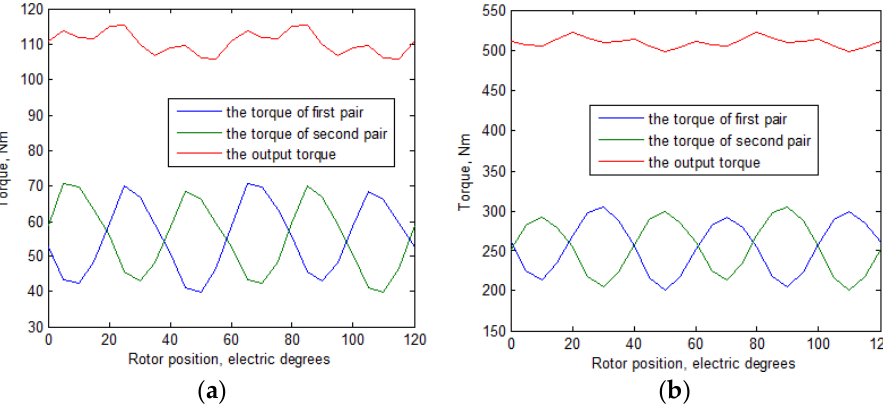
Figure 11. The torque ripple of the individual SRSC and the symmetrized (output) torque ripple after optimization: ( a ) at 3450 rpm; ( b ) at 750 rpm.